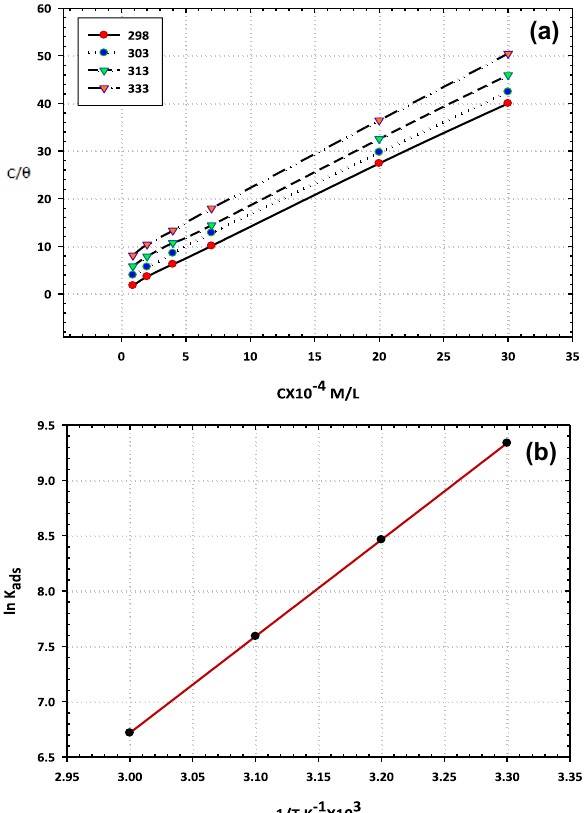
Figure 5. Langmuir ( a ) and Temkin ( b ) isotherms for adsorption of the ionic liquid on the carbon steel in 3.5% NaCl solutions.